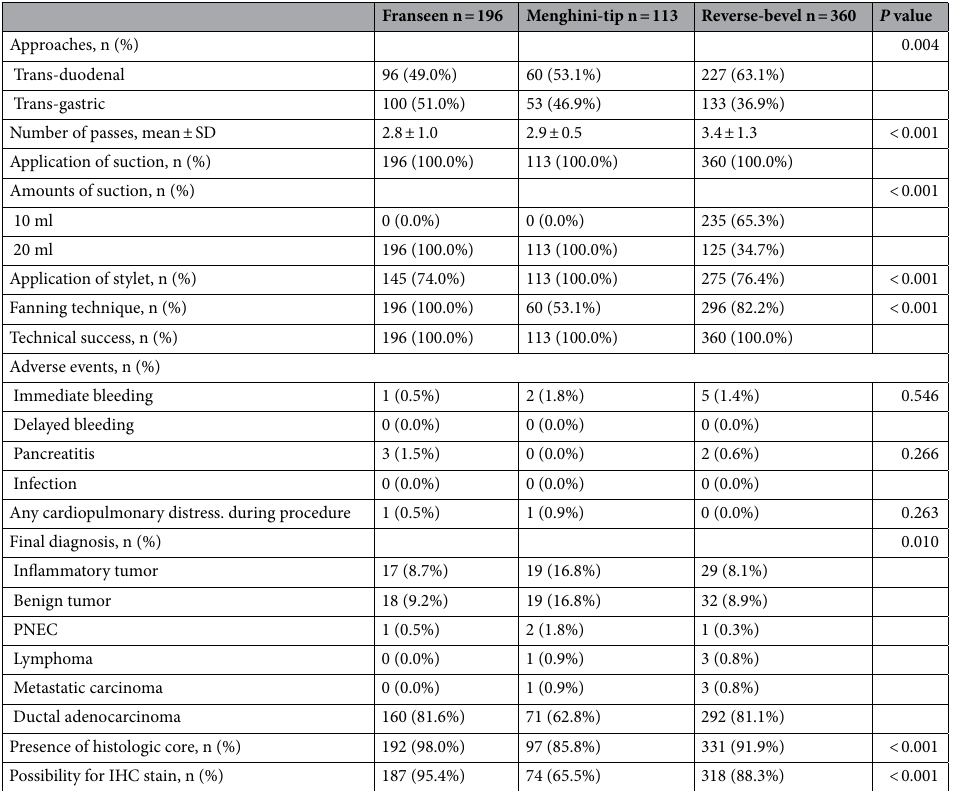
Table 2. Comparison of procedure-related outcomes between the three groups. IHC, immunohistochemical; NET